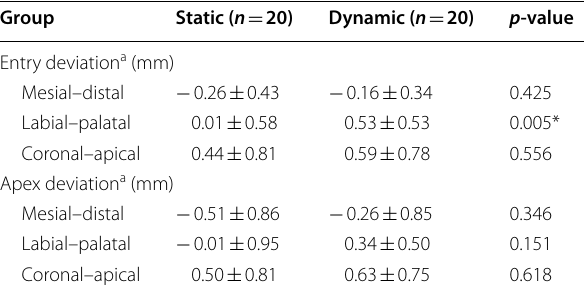
Table 3 The secondary outcomes of deviations at mesial–distal, labial–palatal, and coronal–apical directions (mean